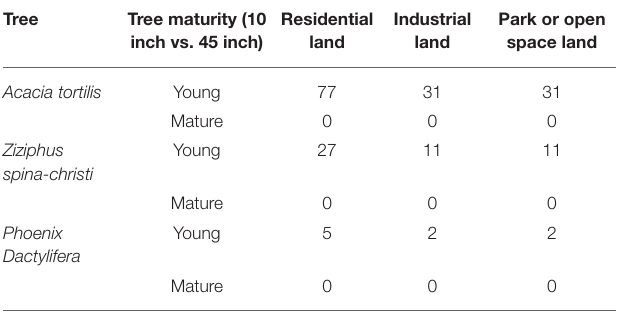
TABLE 2 | The annual increase in property value (US$) of young vs. mature urban trees when planted in different locations.